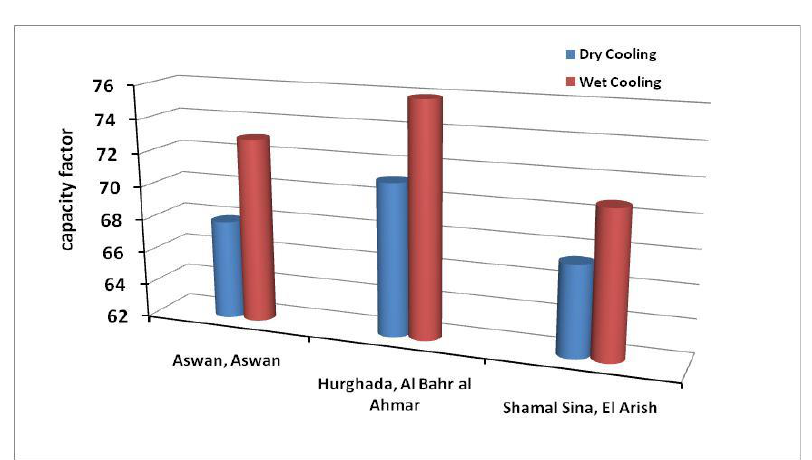
Fig. 7. Annual energy (electrical) for dry and wet cooling.